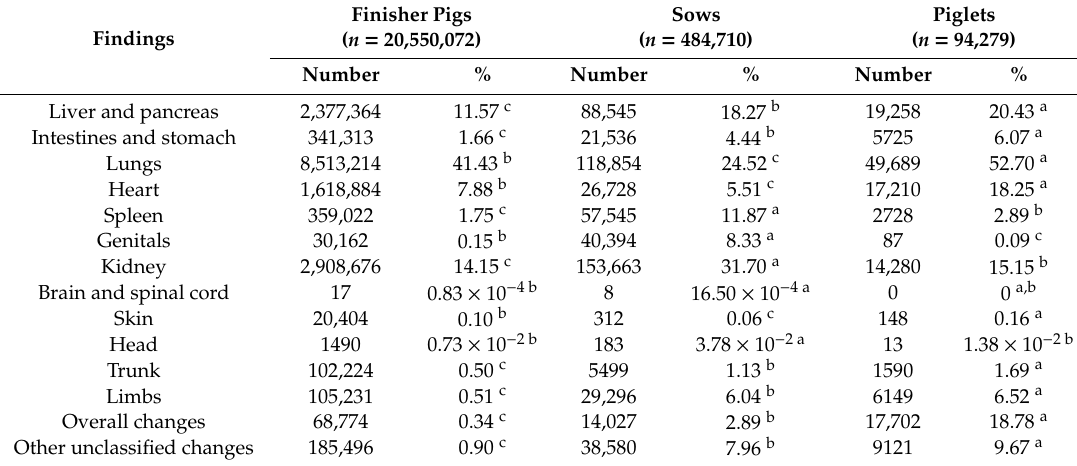
Table 1. Comparison of patho-anatomic findings by individual organs and body parts in finisher pigs, sows and piglets slaughtered in the slaughterhouses in the Czech Republic from 2010 to